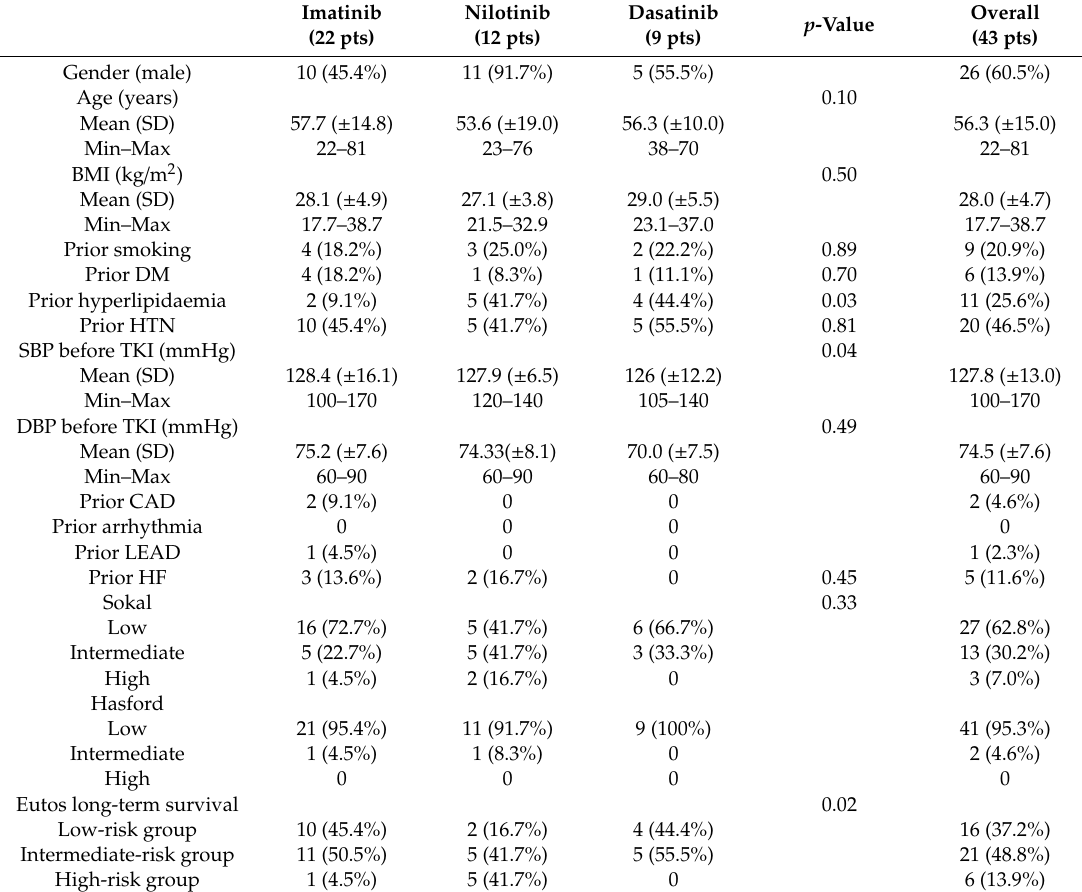
Table 1. Clinical features of 43 chronic myeloid leukaemia patients at the time of